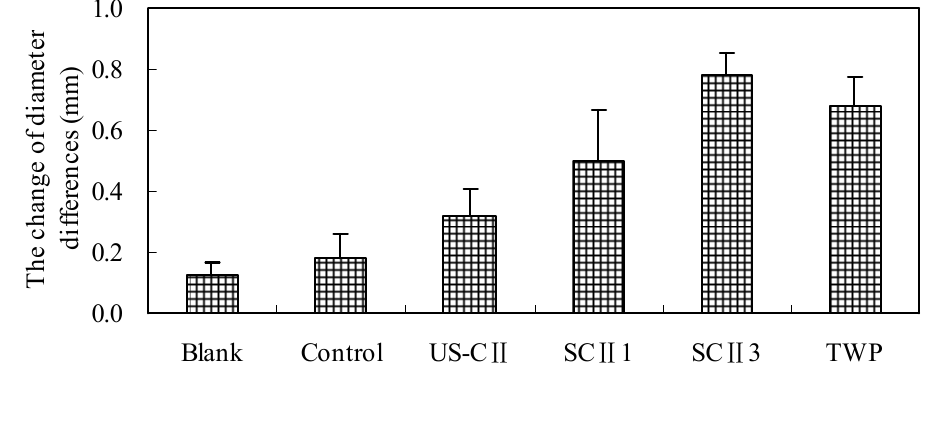
Figure 2. The change of diameter differences between left and right ankle joint from Day 14 to Day 28 (n = 10/group): diameter difference between the right ankle joint and the left ankle joint on Day 28 was subtracted from diameter difference between the right ankle joint and the left joint on Day 14, the values of blank group, control group, US-CII group, SCII 1 group, SCII 3 group and TWP group were 0.13 mm, 0.18 mm, 0.32 mm, 0.50 mm, 0.78 mm and 0.67 mm,